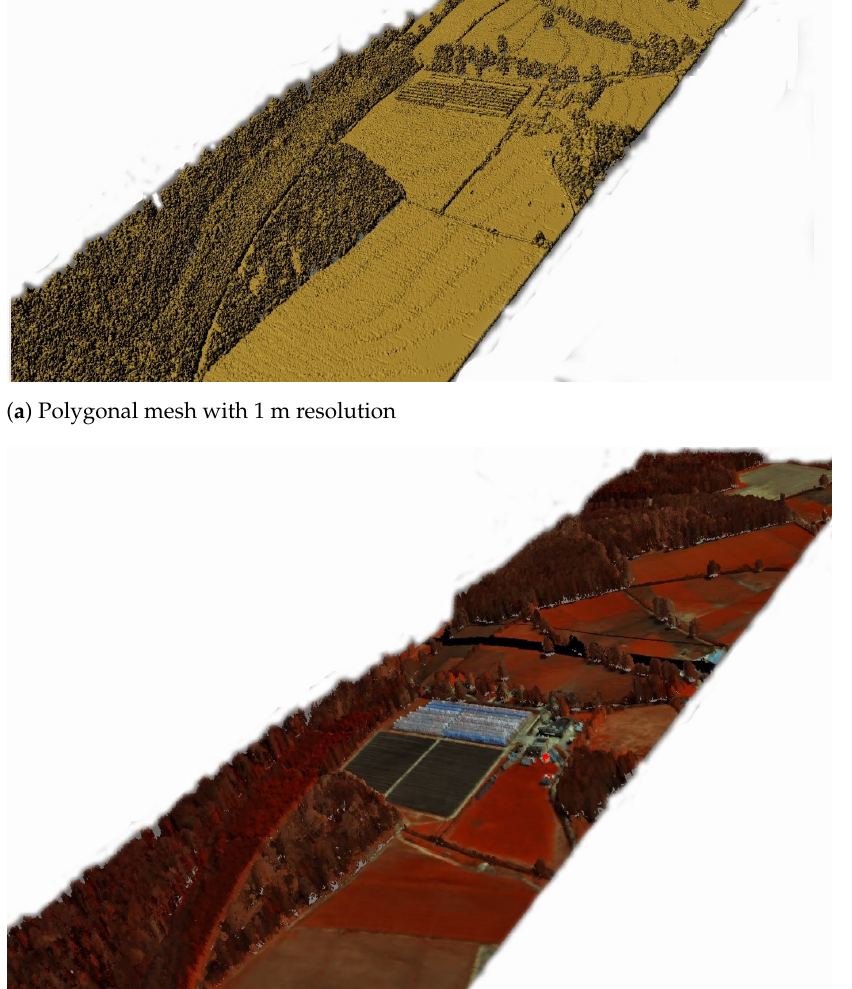
Figure 2. Example of polygonal models created from the voxelised FW LiDAR using the Marching Cubes algorithm